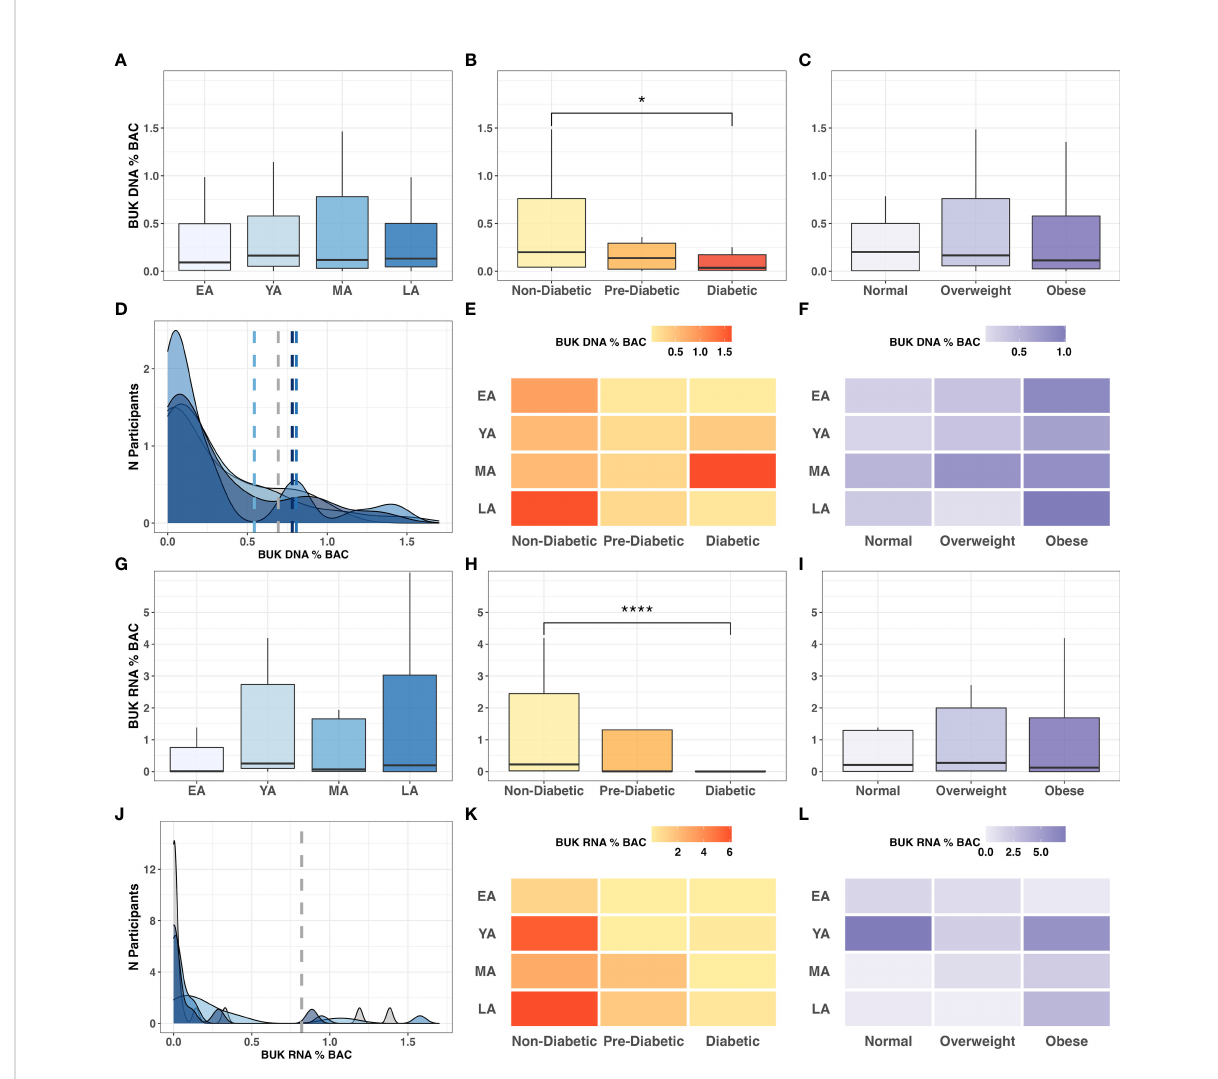
FIGURE 7 BUK gene abundance and expression relative to BAC across age, T2DM and BMI categories. Intergroup comparison of relative BUK gene abundance across (A) age groups (P=0.802 ), (B) T2DM categories ( P=0.032) , and (C) BMI categories ( P=0.736 ). Frequency distribution of participants by age groups among binned BUK DNA values is summarized by a color-coded density plot fi tted over a histogram (D) . Heatmaps indicating the range of relative BUK DNA distributed across age groups and (E) T2DM categories and (F) BMI categories. Intergroup comparison of relative BUK RNA quantitation across (G) age groups ( P=0.151 ), (H) T2DM categories ( P<0.001) . and (I) BMI categories ( P=0.636 ). Frequency distribution of participants by age groups among binned BUK RNA values is summarized by a color-coded density plot fi tted over a histogram (J) . Heatmaps indicating the range of relative BUK RNA distributed across age groups and (K) T2DM categories and (L) BMI categories. Statistical signi fi cance denoted in fi gures above using asterisks as follows: * ( P <0.05); **** ( P